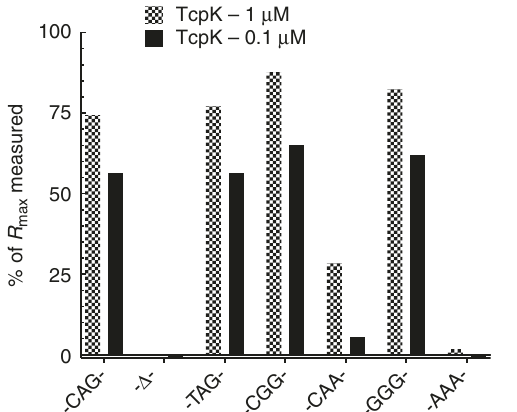
Fig. 4 Binding analysis of TcpK binding to inter TcpK box linker sequence nucleotide derivatives. The 23 bp DNA sequence identi fi ed from the SPR mapping experiment has -CAG- as TcpK box linker sequence. Nucleotide substitutions at the 3-nt linker region are indicated on the graph and - Δ - is a deletion of all three bases. TcpK binding to each fragment was tested with protein concentrations of 1 μ M (checked bars) and 0.1 μ M (solid bars). The responses are expressed as a percentage of theoretical R